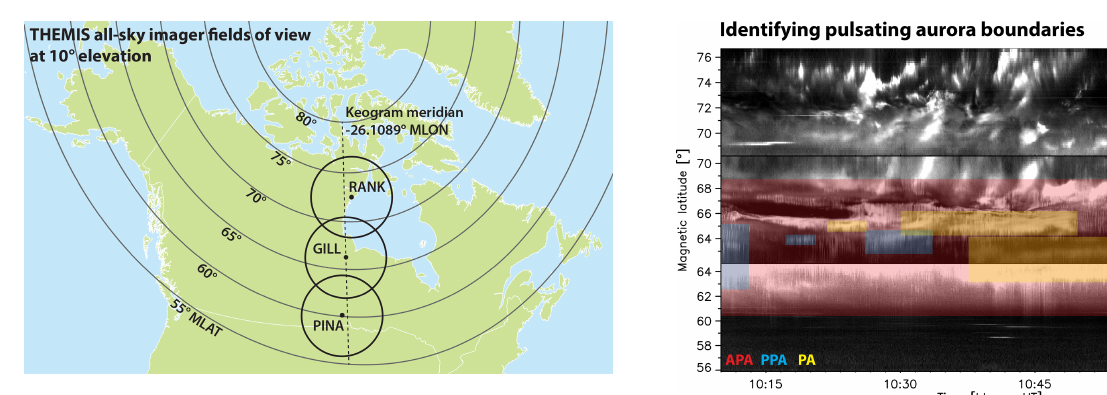
Figure 1. The locations and fields of view of the three THEMIS ASIs utilized in this study. The imagers are located in Rankin Inlet, Nunavut; Gillam, Manitoba; and Pinawa, Manitoba. The fields of view are drawn at 10 ◦ elevation assuming an altitude of 110km.